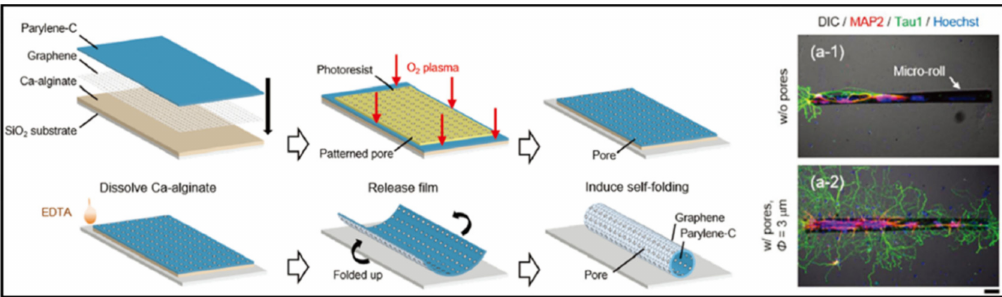
Figure 4. Application of conducting material to neural MPS; Graphene sca ff old for neurite outgrowth. Reproduced with permission from